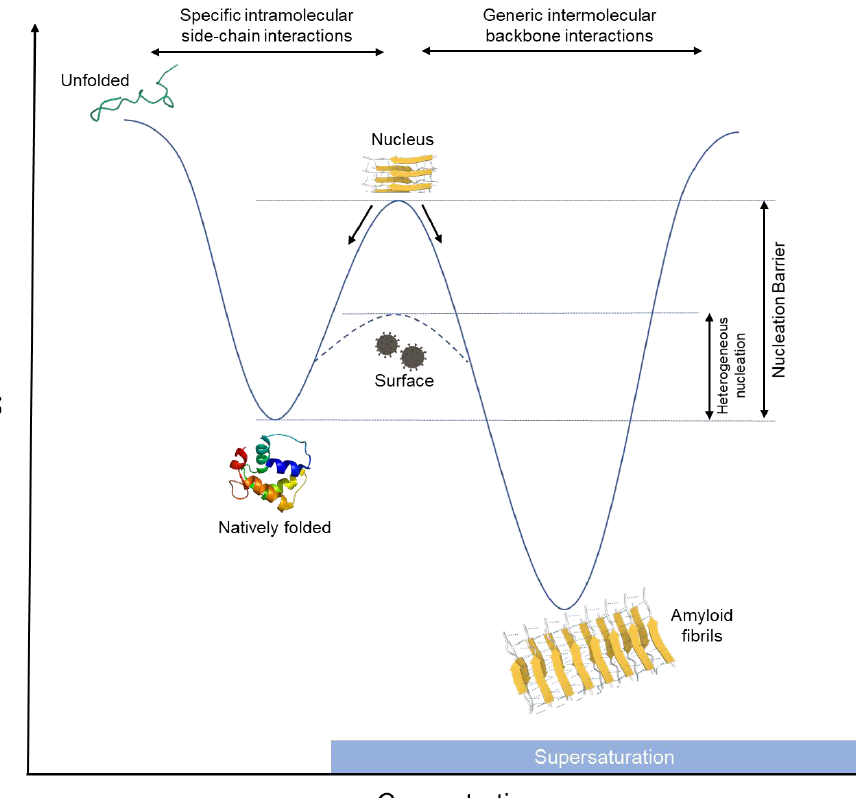
Figure 2. Energy landscape of protein folding. Under unsaturated and saturated conditions, proteins assume their thermodynamically favorable, native conformation based on specific interactions between the sidechains constituting their primary sequence. Under supersaturated conditions, molecular proximity render generic intermolecular backbone interactions more likely; however, phase transition into amyloids will not take place unless a nucleation barrier is crossed. A nucleus of certain size needs to be formed, smaller nuclei dissociate back into monomers, while larger nuclei will trigger phase transition. Nucleation can be triggered by addition of preformed nuclei (seeding) or catalyzed by surfaces, which will lower the energy barrier to nucleation (HEN). The higher the affinity of the protein to the surface, the lower the wetting angle 𝜃 , which will lead to more significant reduction of the nucleation barrier. In this regard, nu- merous interfaces have been shown to induce amyloid nucleation of proteins via HEN.